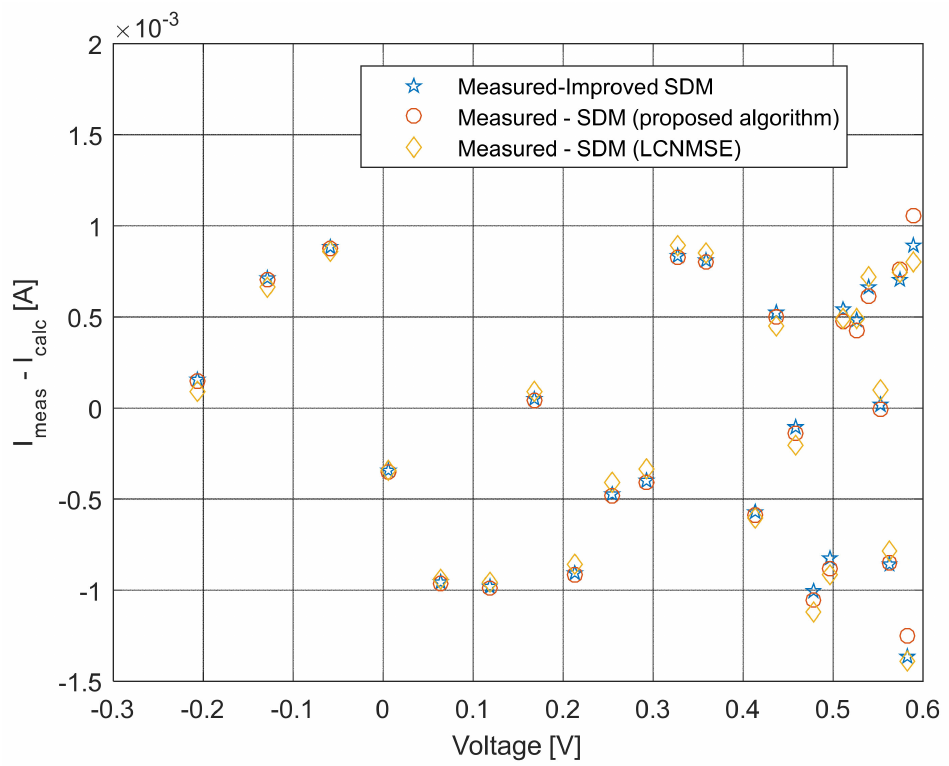
Figure 11. Difference between the measured and calculated current values using different methods for both SDM and